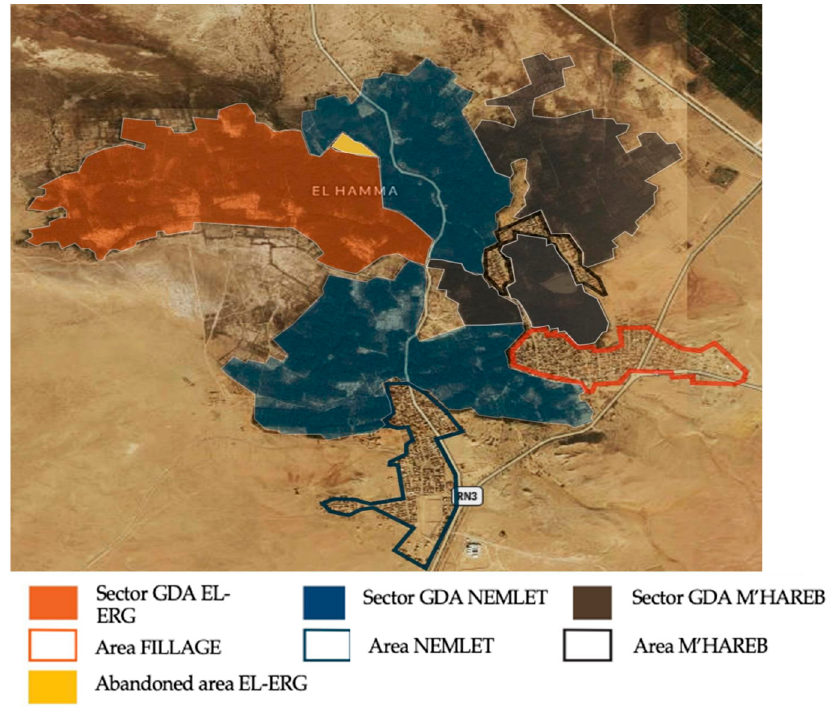
Figure 2. Sectors covered by the 3 Groupements de Développement Agricole (GDA) and districts of El Hamma.